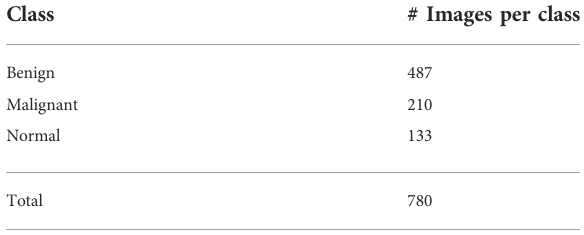
TABLE 1 Three classes in the DBUI